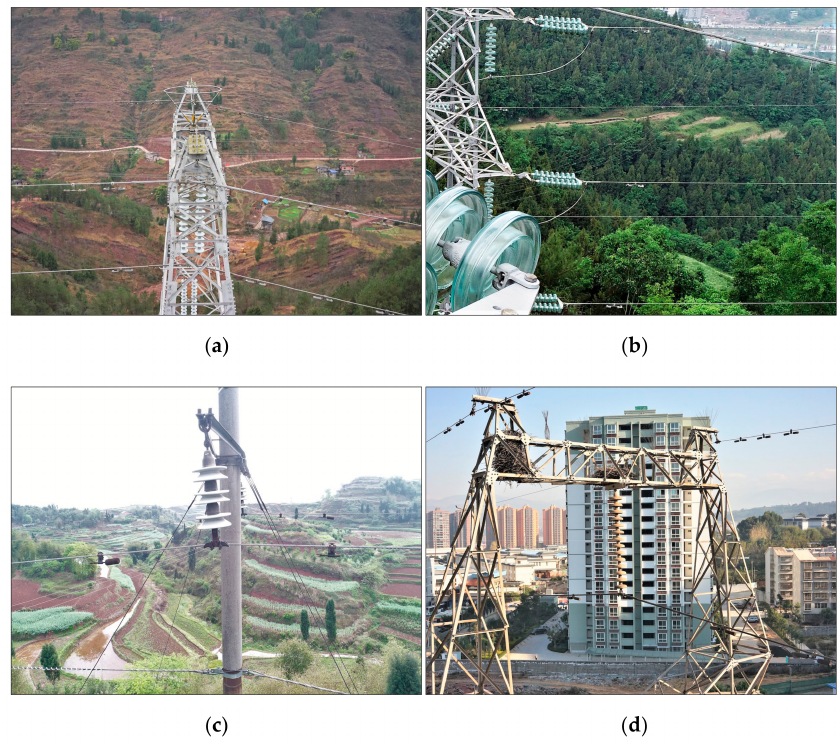
Figure 4. Different types of complex backgrounds in UAV remote sensing images: ( a ) mountainous area; ( b ) forest; ( c ) fields; ( d ) residential area.